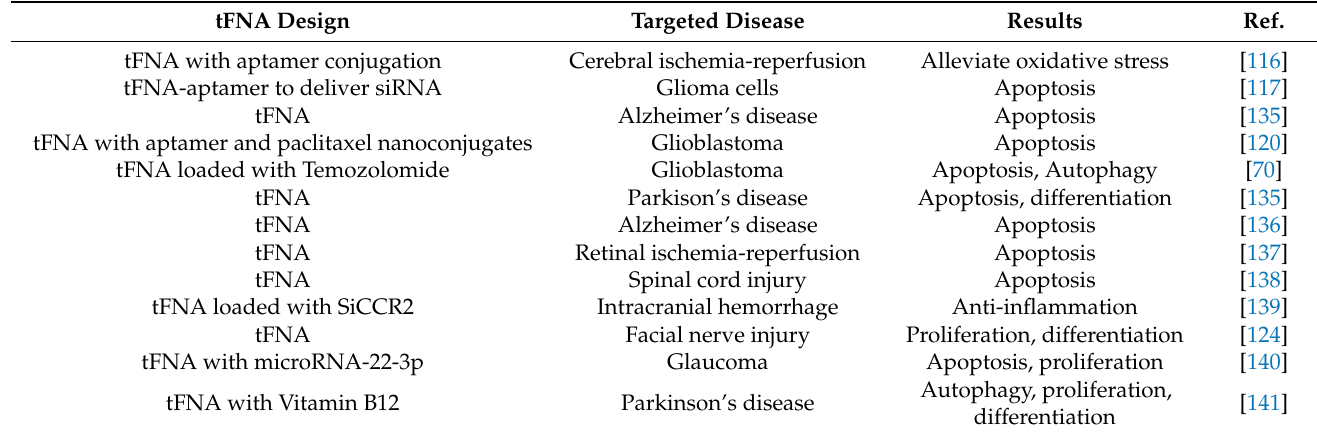
Table 3. Tetrahedral framework nucleic acids applied as therapeutic agents in neural diseases. tFNA Design Targeted Disease Results